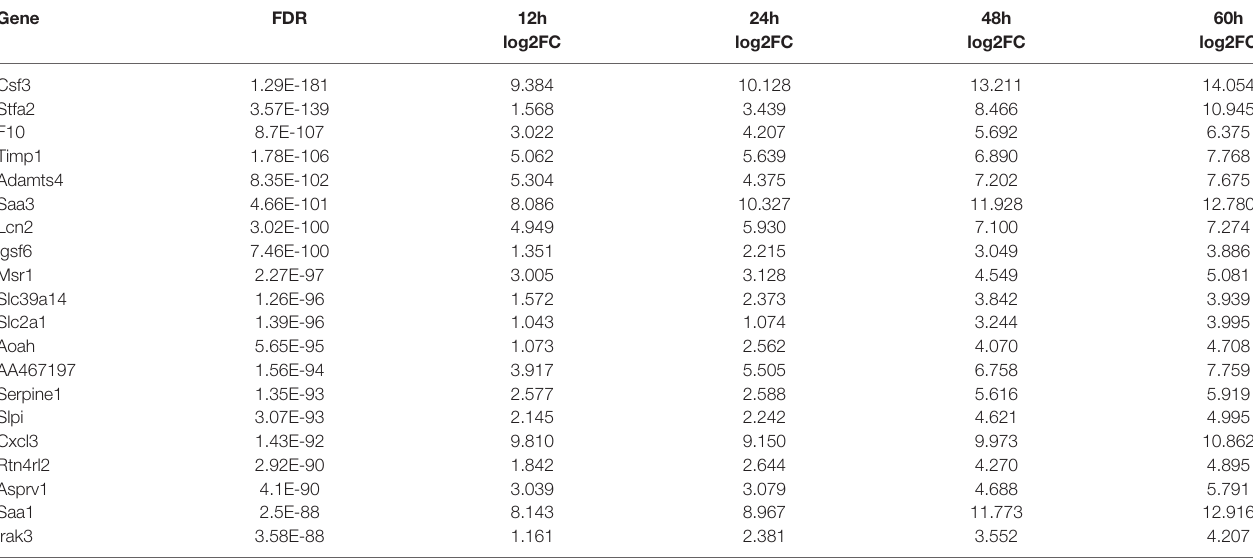
TABLE 2 | Top 20 DEGs that are signi fi cantly up-regulated at different infection time points. Gene FDR 12h 24h 48h